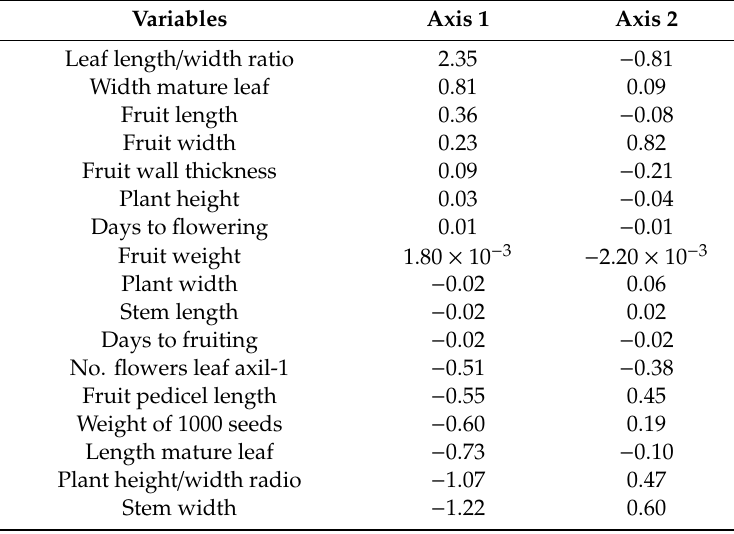
Table 6. Eigenvalues determined by the canonical discriminant function discriminating grouping of Capsicum spp.